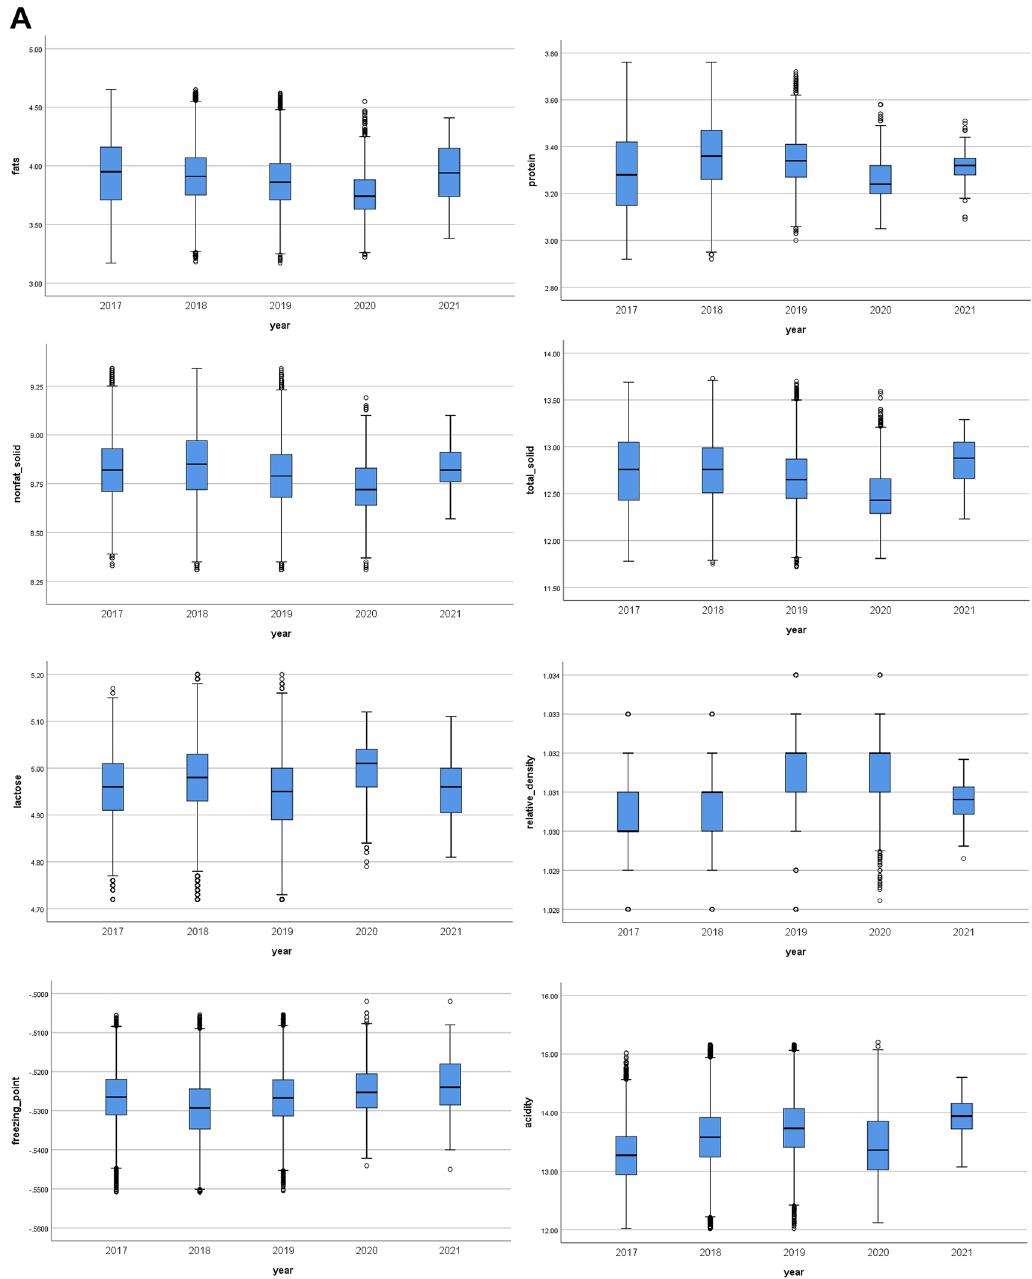
Figure 1. Boxplots of eight compositional features of normal raw milk separated by ( a ) years and ( b ) seasons. Non-fat solid (NFS), total solid (TS), relative density (RD), freezing point depression